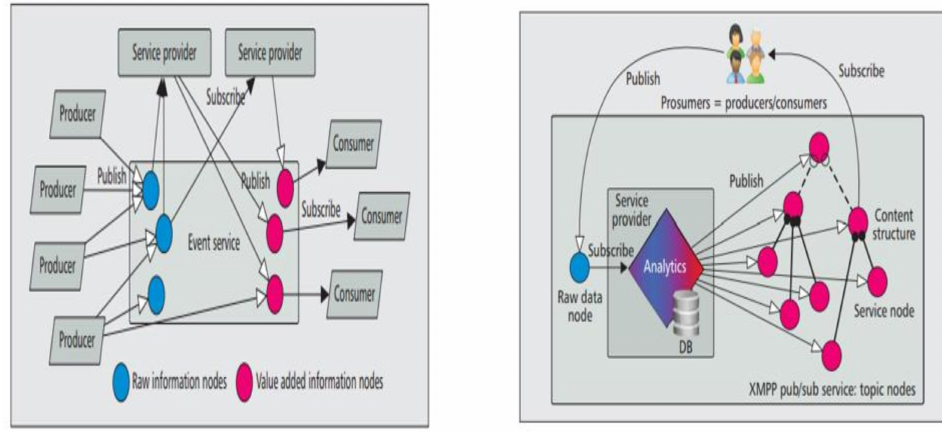
Figure 9. Mobile crowdsensing smart transportation architecture [29].